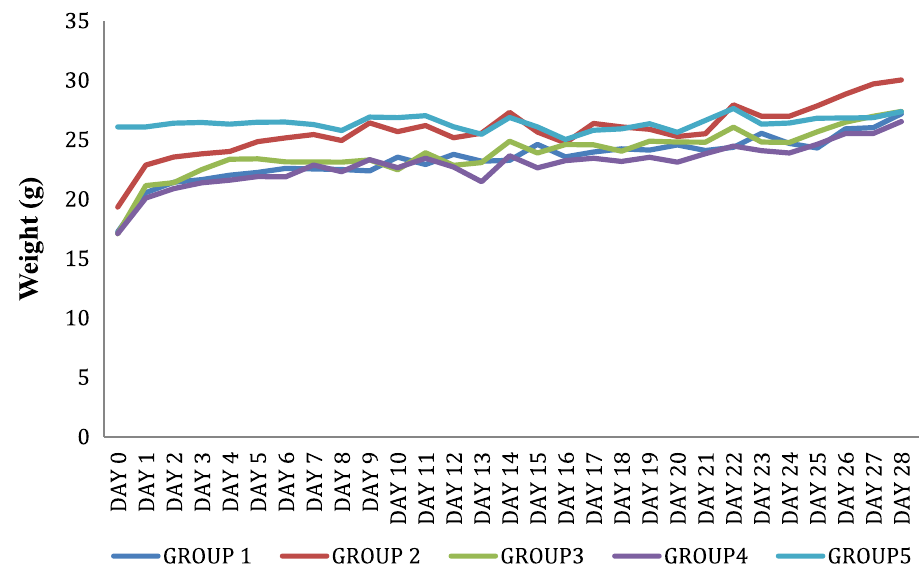
Fig. 4 The effect of Hepatitis B vaccine modulated with eggshell membrane on the body weight of the